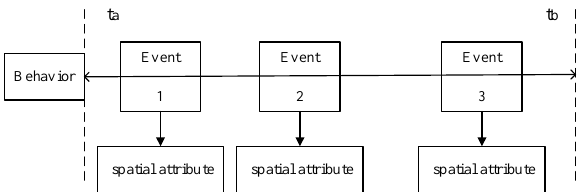
Figure 2. The relationship between behavior and events